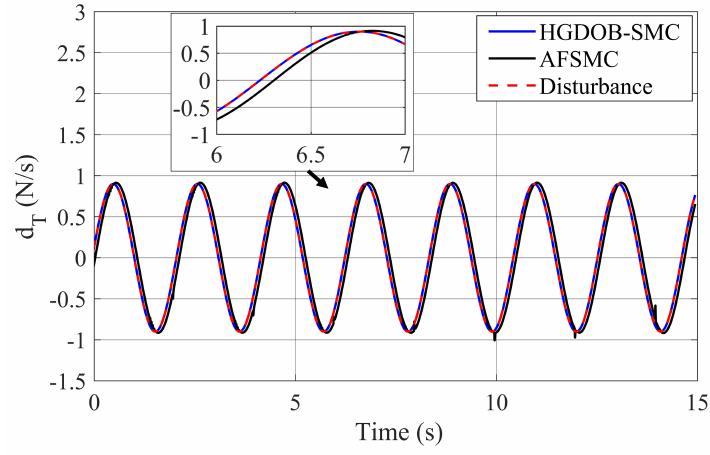
Figure 5. Disturbance d T and estimated value.